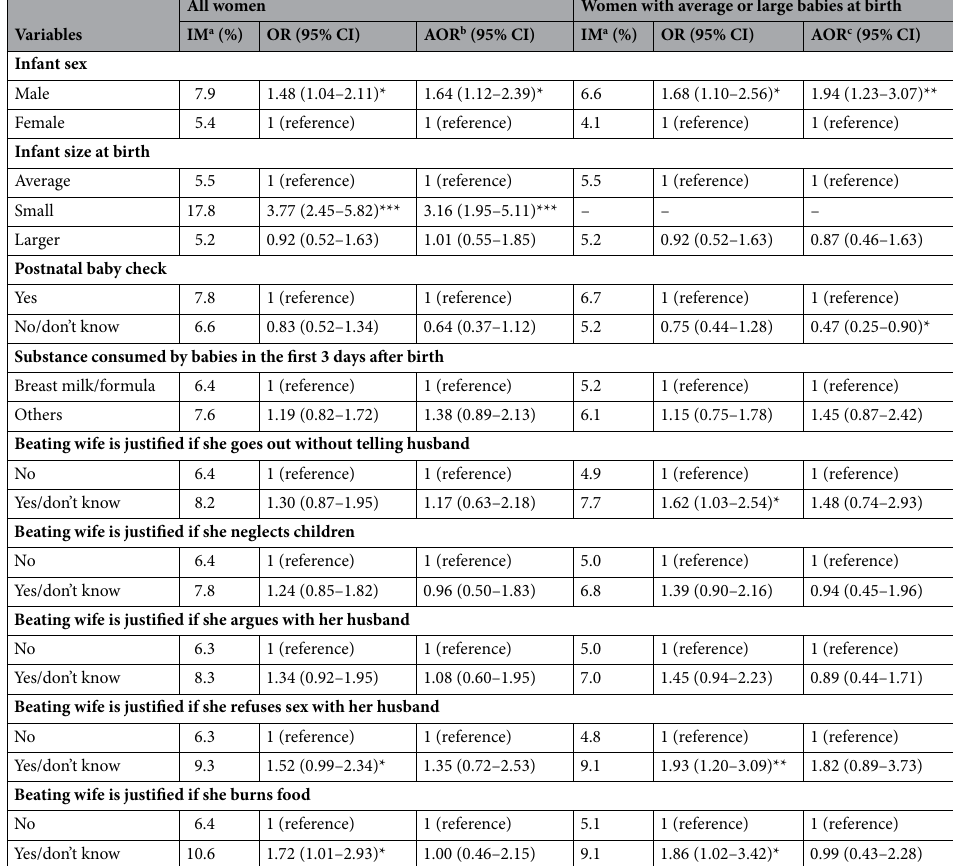
Table 3. Comparison of neonatal factors and attitude towards domestic violence according to infant mortality. IM infant mortality, OR odds ratio, AOR adjusted odds ratio, CI confidence interval. *P < 0.05. **P < 0.01. ***P < 0.001. a Sampling weights were applied. b Adjusted for all variables included in Tables 1, 2, 3. c Adjusted for all variables included in Tables 1, 2, 3 except cesarean